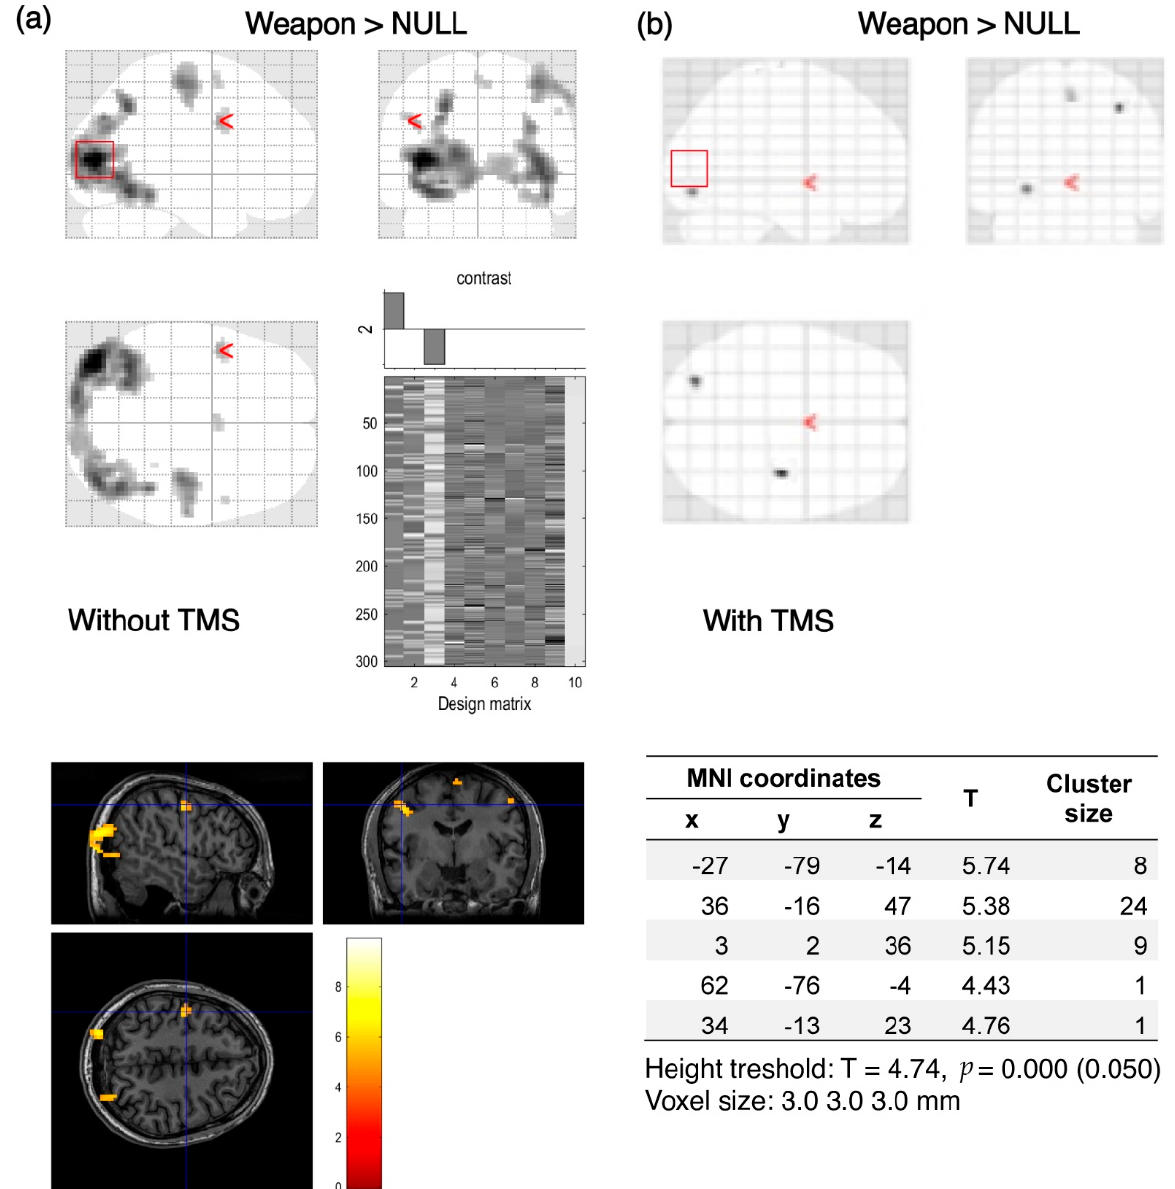
Figure 5. Decrease of BOLD signal activation in response to the visual stimulus of significant significance before ( a ) and after ( b ) using TMS. Visible clear decrease of BOLD signal in the occipital region (red squares) after applying TMS. Table shows 3 local maxima more than 8.0 mm apart. Visibly clear decrease of BOLD signal in the occipital region after applying TMS. “Weapon” denotes activations evoked by images related to the military compared to brain activation when no stimuli were presented (NULL).